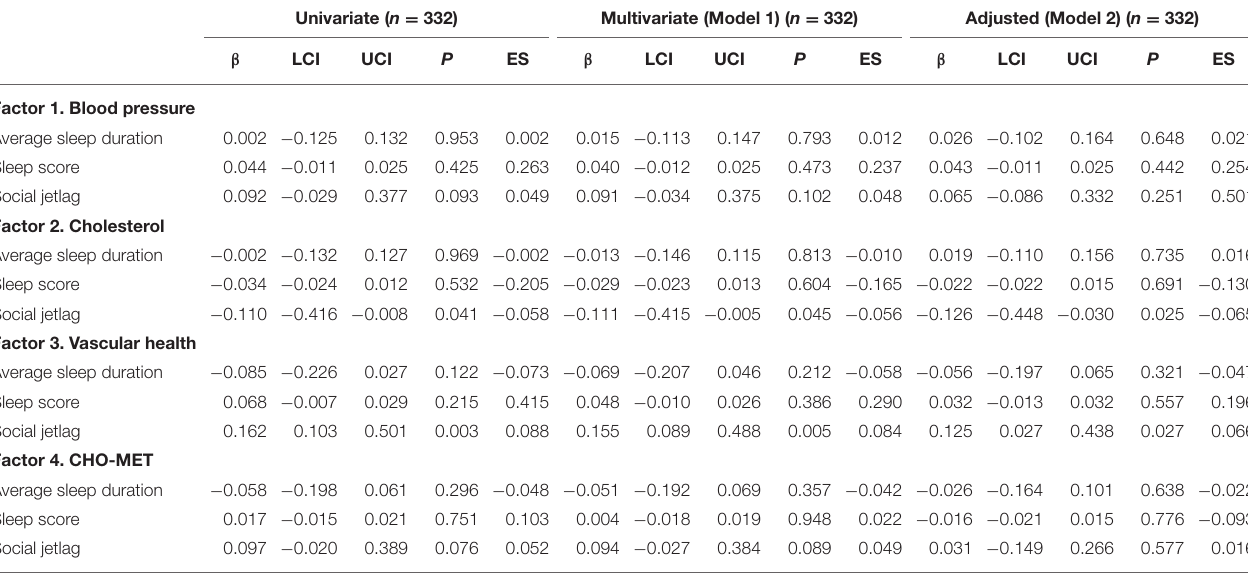
TABLE 3 | Linear associations between cardiometabolic risk factors and sleep measures ( n =